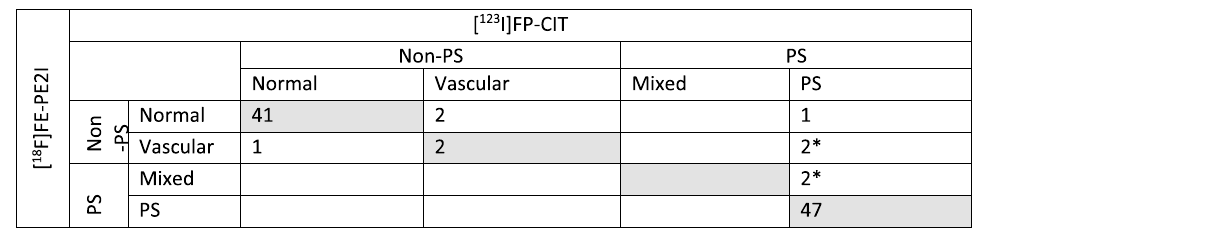
Table 2 Agreement between [ 123 I]FP-CIT and [18F]FE-PE2I